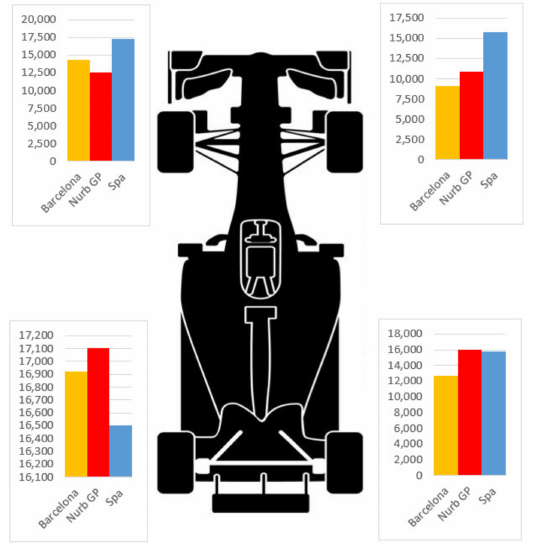
Figure 7. Tire energy sensitivity to different tracks. Values are reported in kJ.